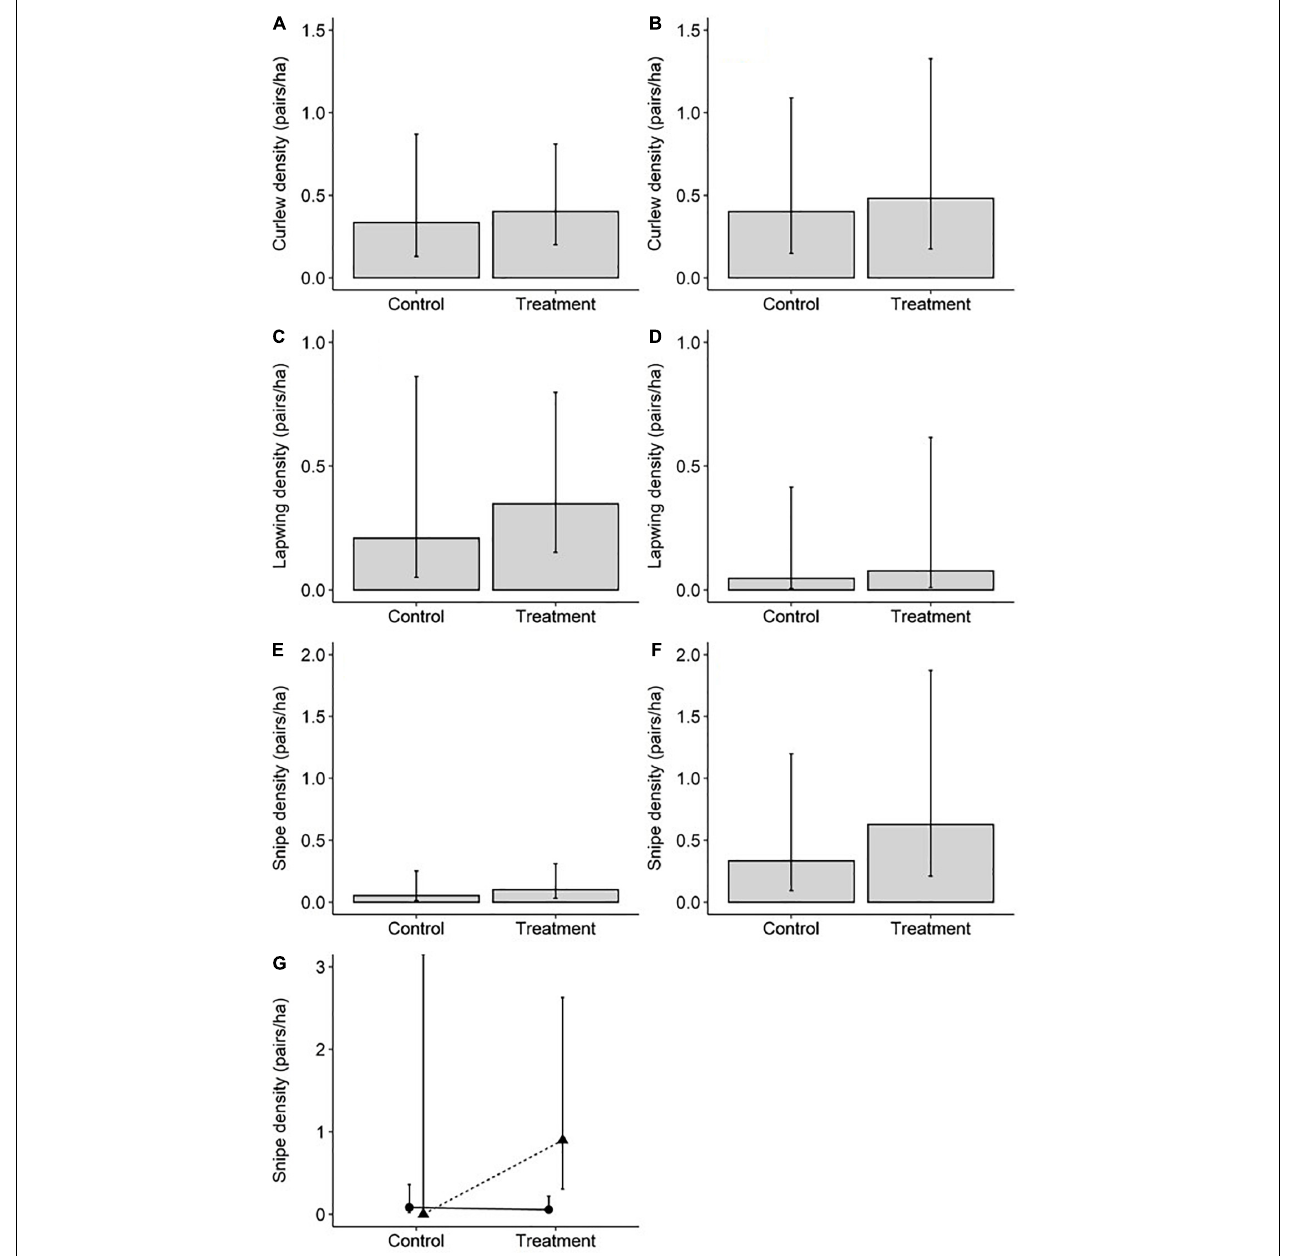
FIGURE 2 | Poisson model (main effects only models) predicted breeding wader pair densities in control fields and treatment fields within Geltsdale [left hand column; n = 18 fields (9 control and 9 treatment)] and the SWP [right hand column; n = 25 fields (13 control and 12 treatment)] when taking into account rush cover, woodland distance, and soil conditions (moisture, pH, and penetration resistance) for Curlew (A,B) , Lapwing (C,D) , and Snipe (E,F) . Bars represent model predicted densities, and errors represent model predicted 95% confidence intervals. The best fitting model (judged by AICc values) for Snipe densities included an interaction between region and treatment with model predicted densities (G) being represented by triangles (SWP) and circles (Geltsdale); error bars again represent 95% confidence intervals but note that for Snipe densities in SWP control fields these are infinite due to singularity issues with the model as no Snipe were observed in such